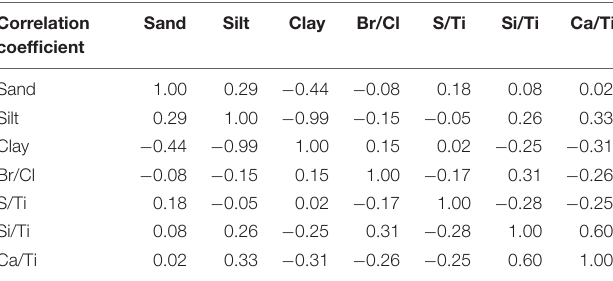
TABLE 3 | Correlation matrix between grain size component and element ratio.